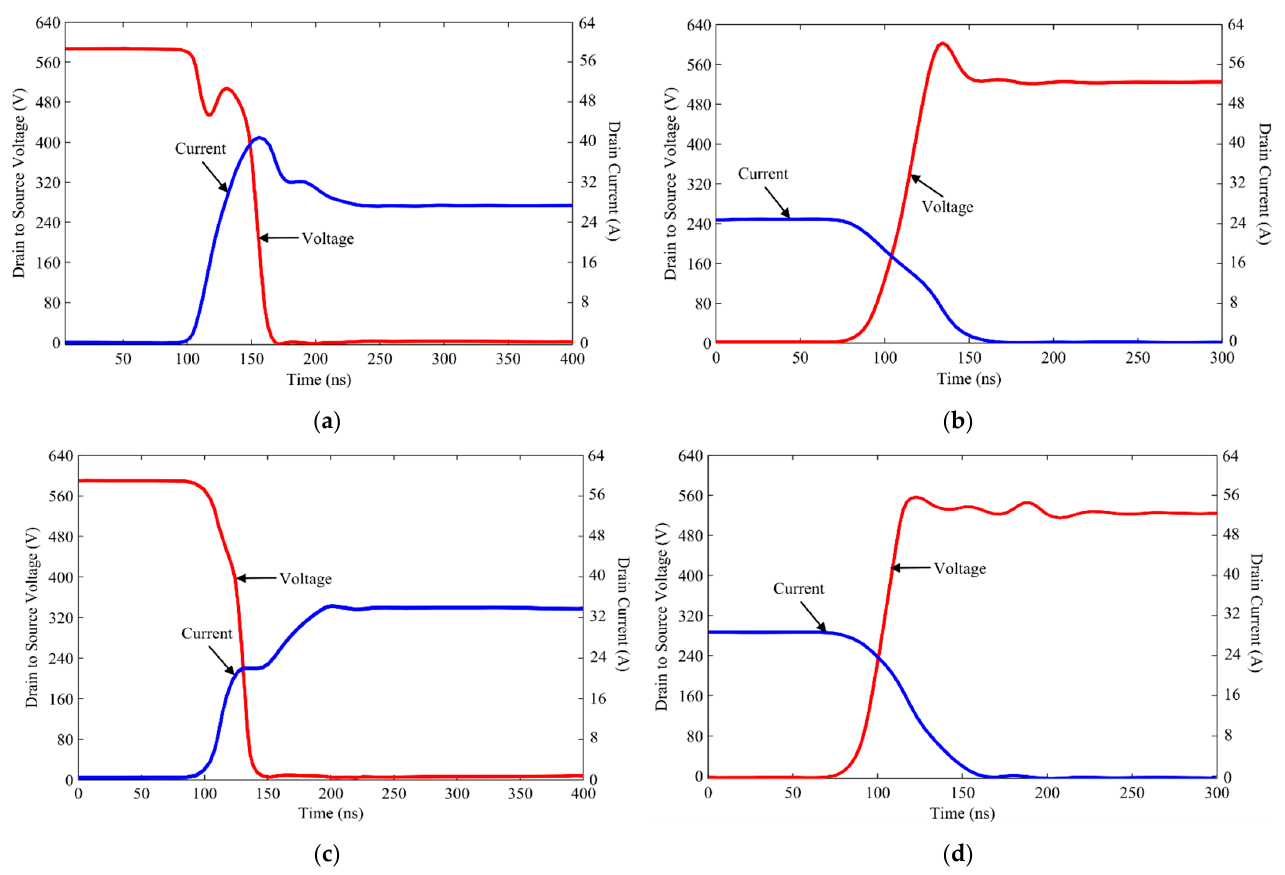
Figure 11. Switching curves of S 2 obtained from LTSpice: ( a ) switch turn ON for conventional ANPC, ( b ) switch turn OFF for conventional ANPC, ( c ) switch turn ON for hybrid ANPC, ( d ) switch turn OFF for hybrid ANPC.